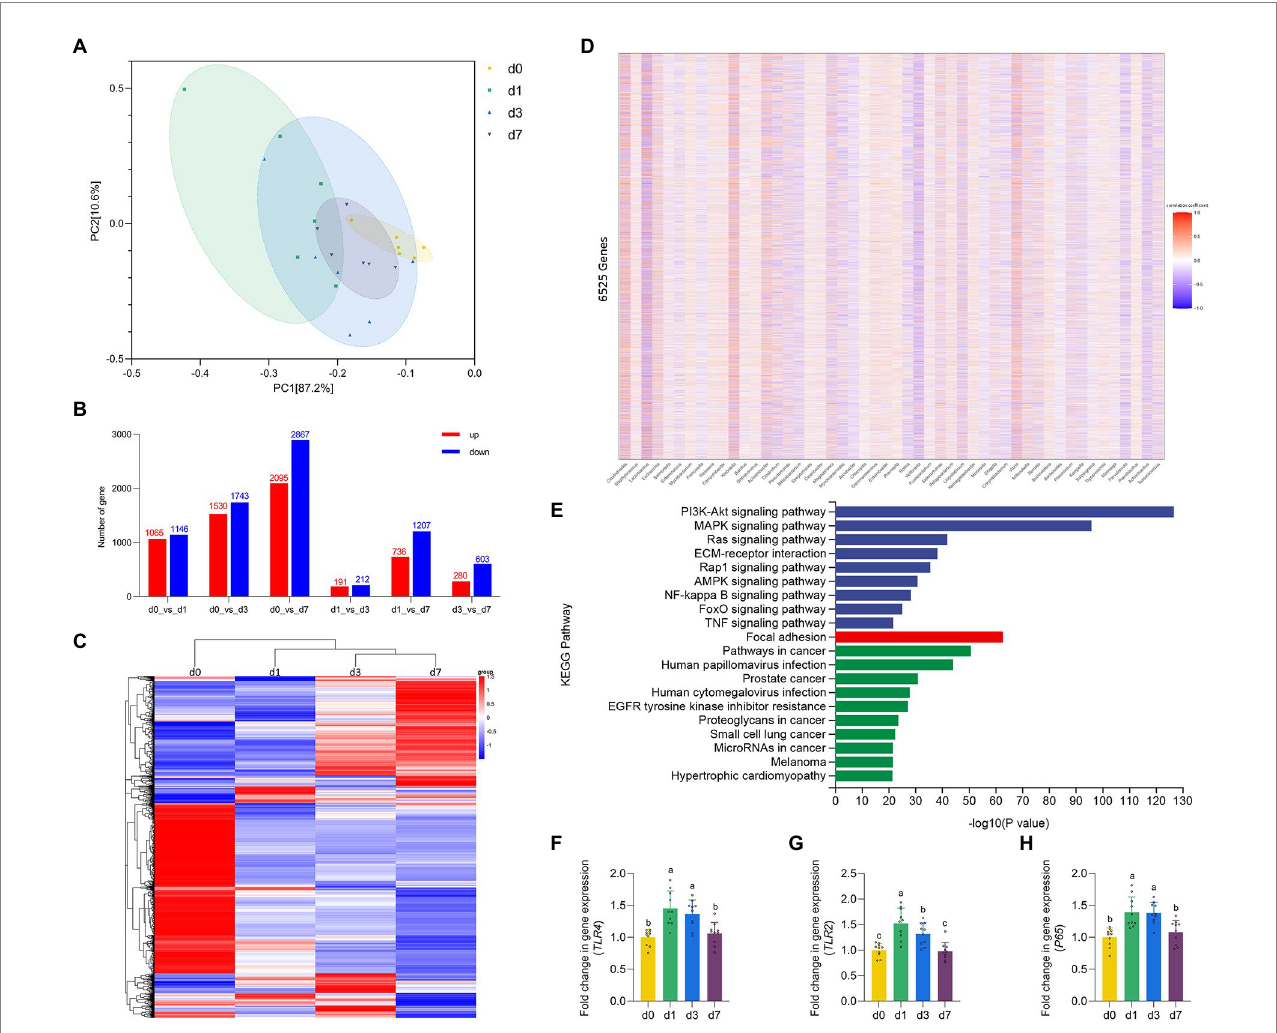
FIGURE 3 Dynamic gene expressions during intestinal development progression in piglets. (A) Principal component analysis (PCA) based on the gene expression in jejunal mucosa of piglets at four time points (d 0, 1, 3, and 7). (B) Histogram of differentially expressed genes in jejunal mucosa of piglets at four time points (d 0, 1, 3, and 7). (C) Cluster analysis results of differential expression of gene in jejunal mucosa of piglets at four time points (d 0, 1, 3, and 7). (D) Spearman correlation analysis between the top 50 species level differential bacteria screened in the metagenomic results and 6,525 defferent expreesed genes. (E) KEGG pathway enrichment analysis of genes highly associated with different bacteria. (F–H) The mRNA expression of TLR4, TLR2 and P65 in jejunal mucosa of piglets at four time points (d 0, 1, 3, and 7). Data were shown as means ± standard deviations. Mean value without the common letter on data bar in each figure indicated that the difference was significant ( p <